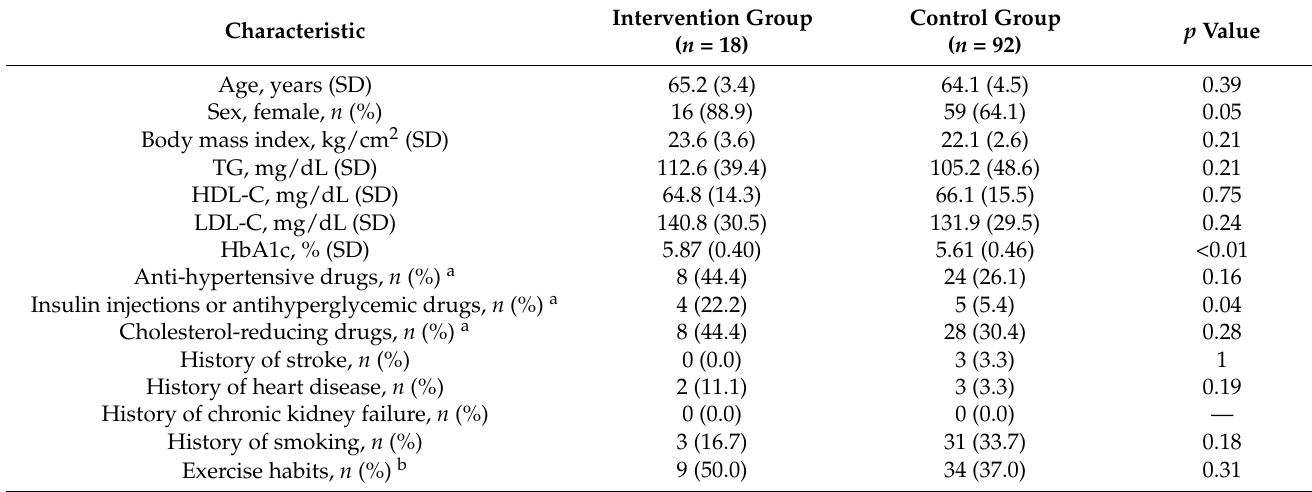
Table 1. Baseline characteristics.